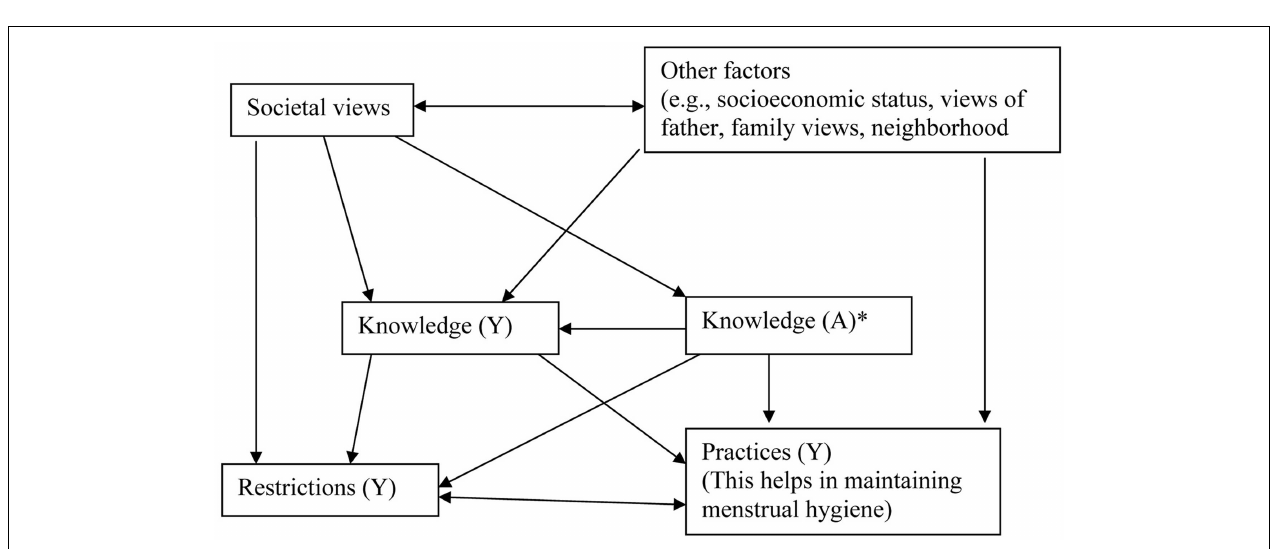
FIGURE 1 |The factors influencing the menstrual hygiene practices and restrictions among young women .Y, young women; A, adult women. *Knowledge (A) among adult women is basically their own knowledge and what they know about knowledge and practices followed by young